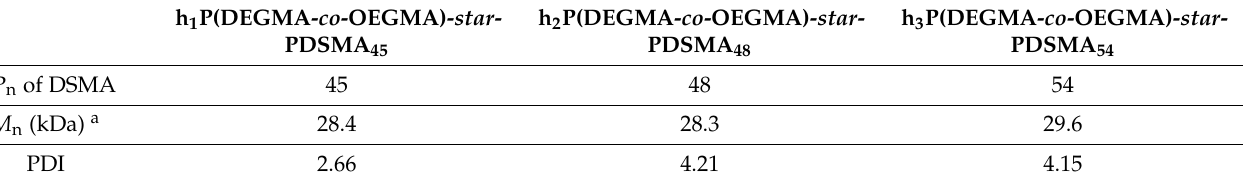
Table 4. Structure data of the three hyperbranched multiarm copolymers.